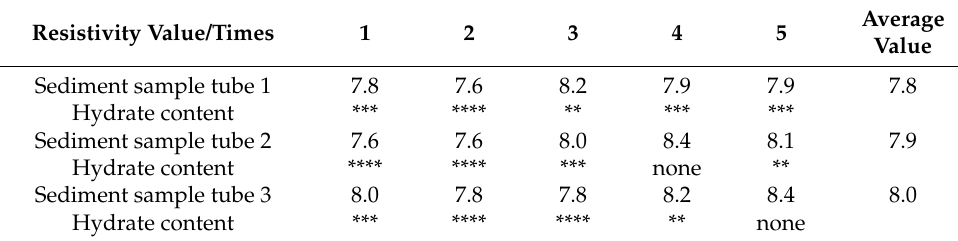
Description: * Represents gas hydrate